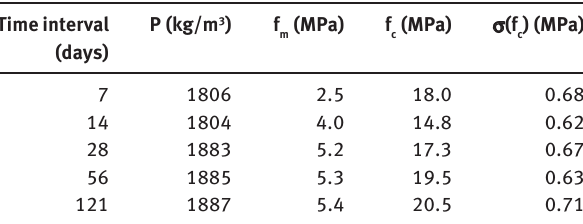
Table 4 Densities and mechanical properties of hardened fine grained concrete (mix AI).